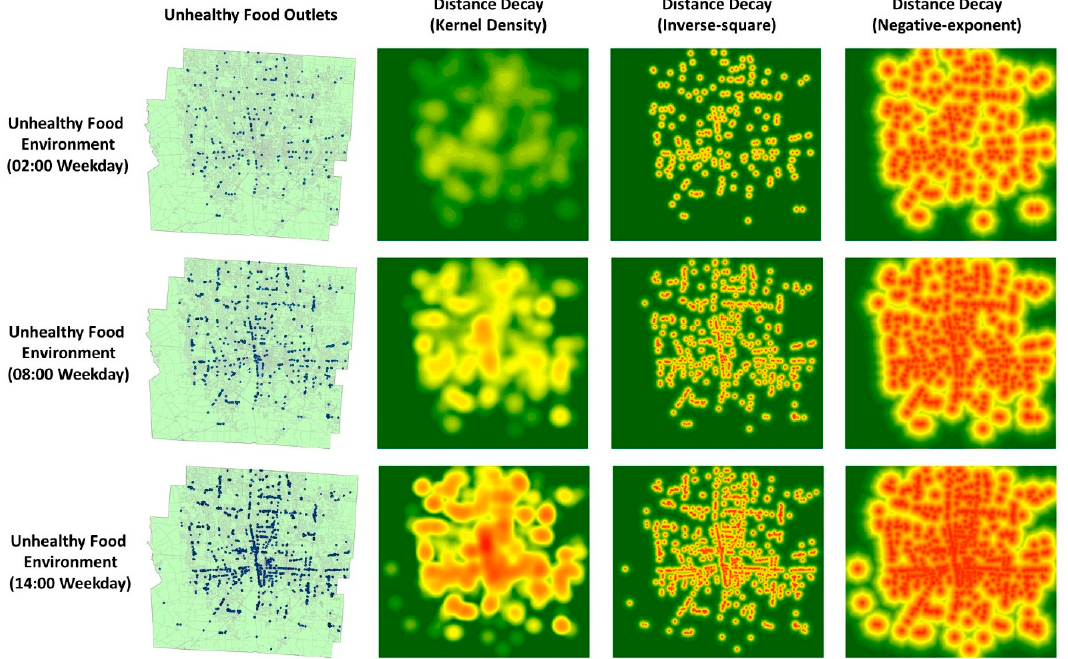
Figure 3. The food environment layers at different time of a day generated by the three different distance-decay methods (the food environment layers with spatial resolution of 100 m × 100 m are used in this figure to illustrate the three distance-decay